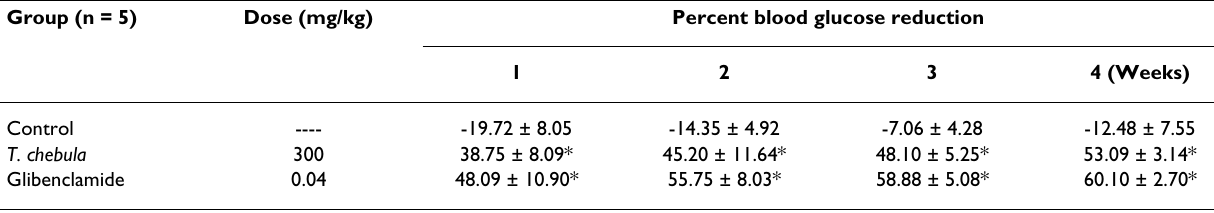
Values are represented as mean ± S.E.M.; n = number of animals per group Significant difference from control group at identical times, *P < 0.01